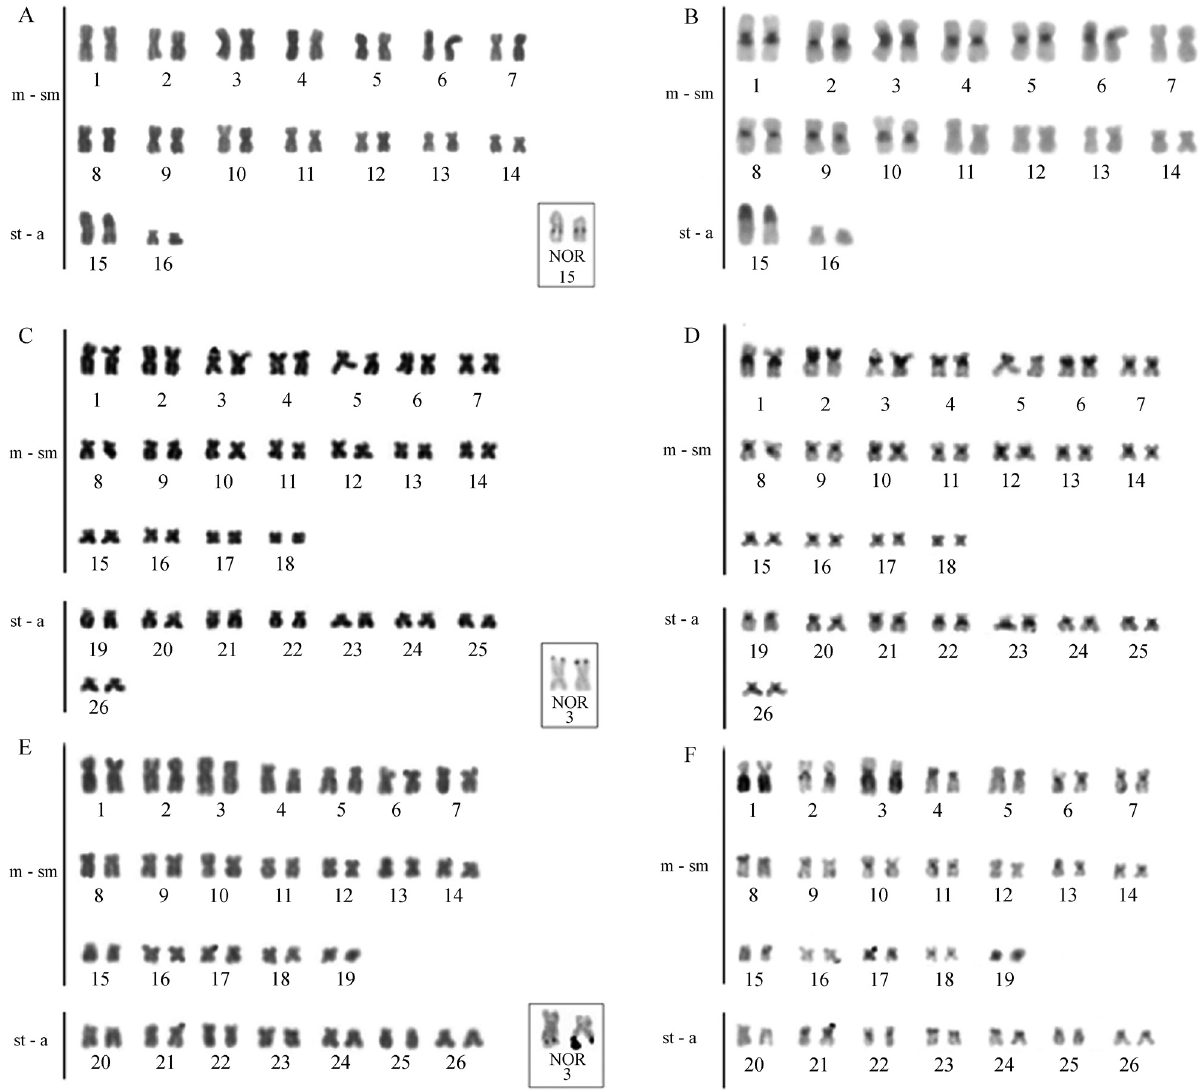
Figure 3 - Karyotypes submitted to conventional staining and C-banding: A and B - Sternarchorhamphus muelleri , C and D - Parapteronotus hasemani ; and E and F - Sternarchogiton preto . Abbreviations: m-sm = metacentric-submetacentric; st-a =